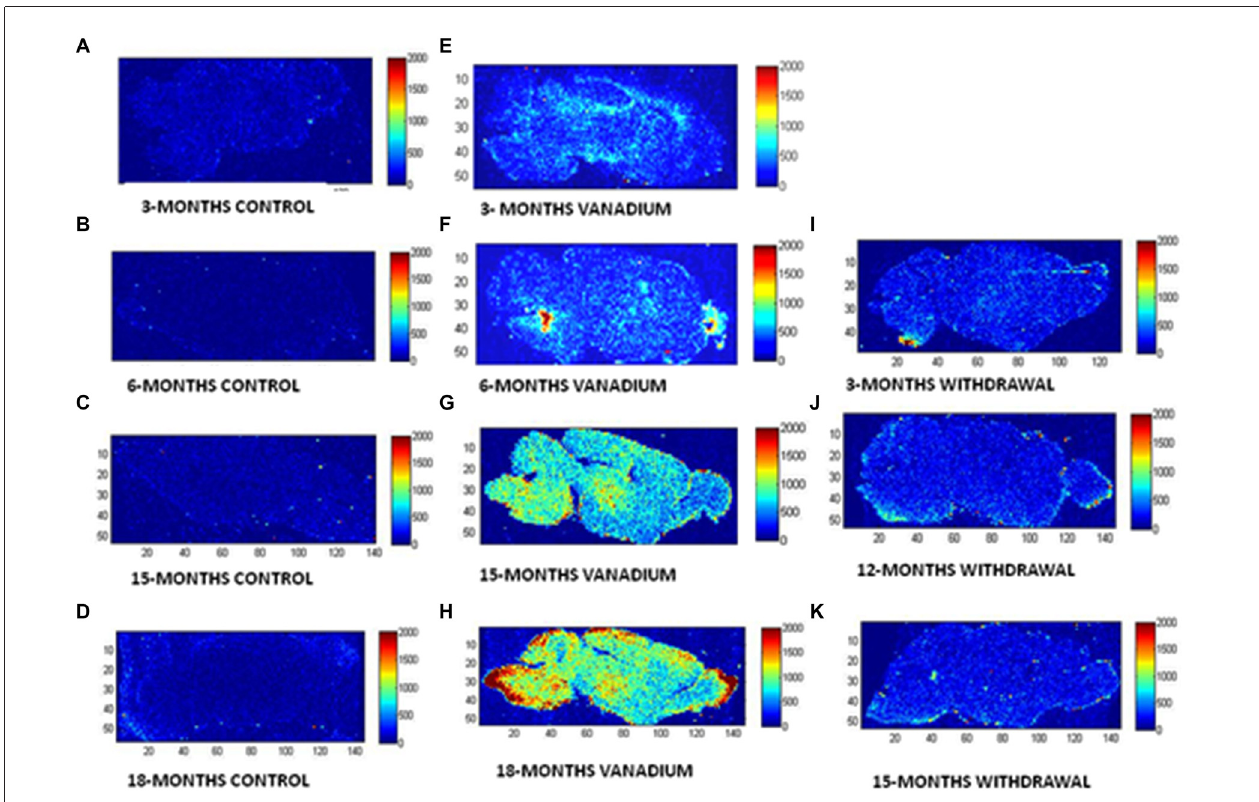
FIGURE 1 | Laser ablation-inductively coupled plasma-mass spectrometry (LA–ICP–MS) is used to reveal and quantify metals in brain tissue. To show the microspatial distribution of vanadium metal within anatomical regions of mice brain after chronic exposure. BASAL INDICES: 80 µ m × 80 µ m square laser spot, 3% laser power with 0.4 J/cm 2 confluence, 320 µ m/s laser speed, 20 Hz, 0.25 s Integration. ( A–D , control brains), ( E–H , vanadium exposed brains), ( I–K , withdrawal brains) at 3, 6, 15 and 18 months time points of